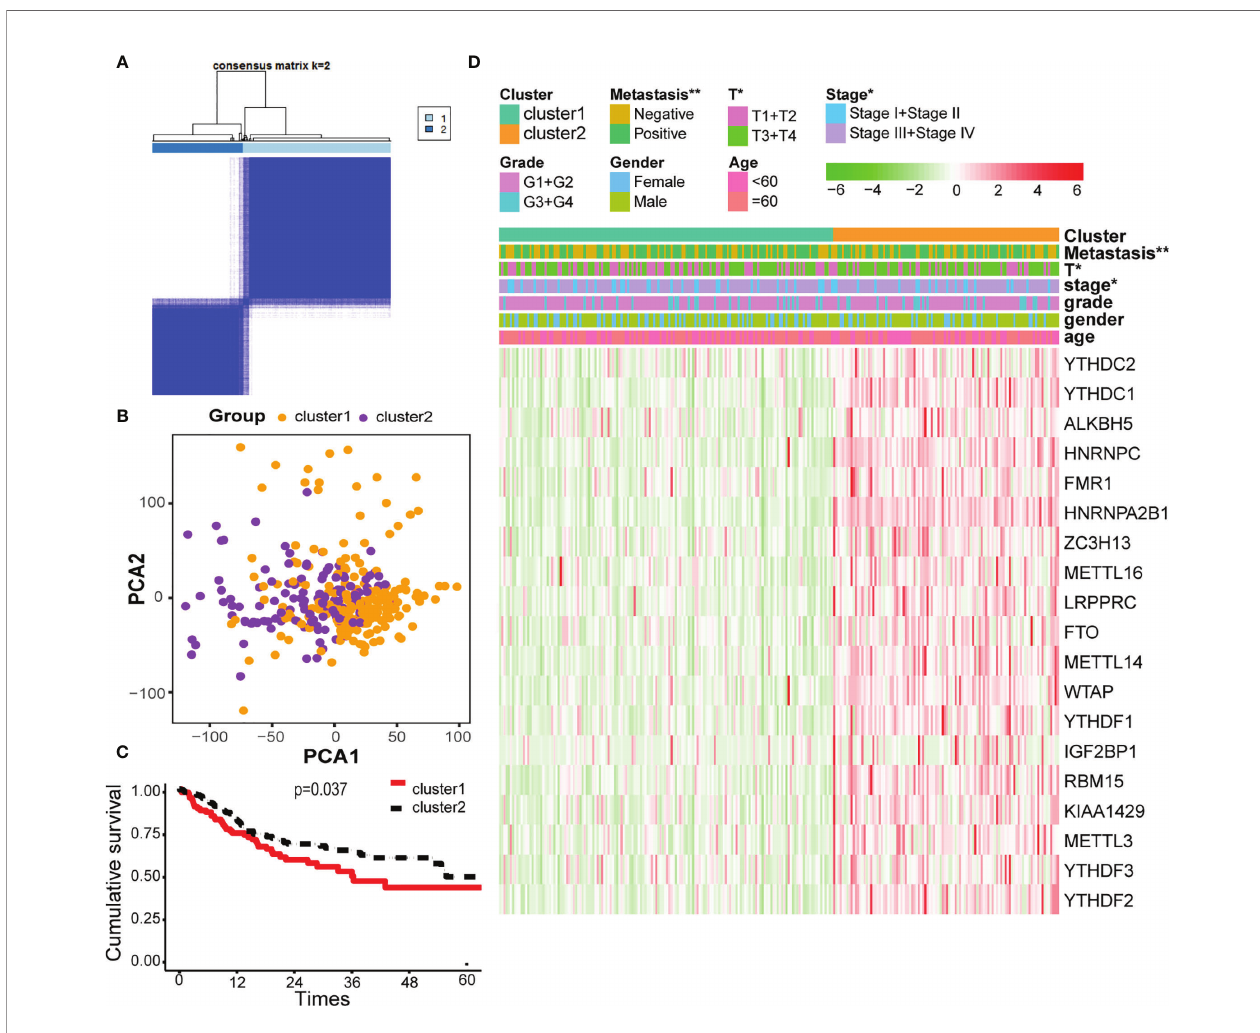
FIGURE 2 | Cluster analysis based on m 6 A-related genes. (A) Consensus matrix for the two groups from the TCGA database. (B) Principal component analysis (PCA) score plot of the two clusters has few overlaps. (C) Overall survival analysis between cluster 1 and cluster 2. (D) Heatmap of the 19 m 6 A-related genes, showing distinct expression pro fi les for correlation of cluster analysis and clinical characteristics. * and ** indicated p<0.05 and p<0.01,